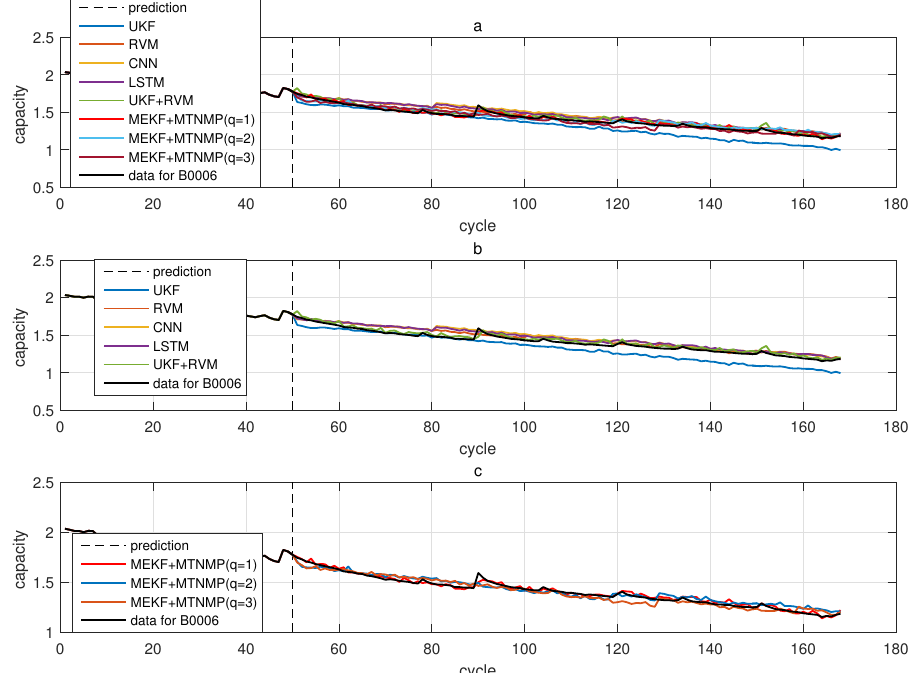
Figure 8. The simulation diagram of B0006 predicted from the 50th time. ( a ) is the experimental diagram of all methods, ( b ) is other methods used for comparison in ( a , c ) is the method proposed in this paper in ( a